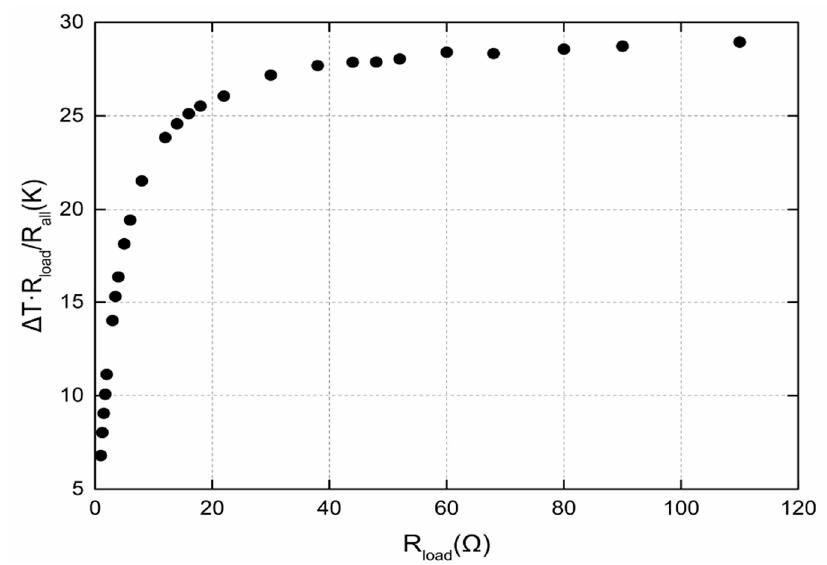
Figure 4. Changing tendency of ∆ TR load / R all on the load resistance.